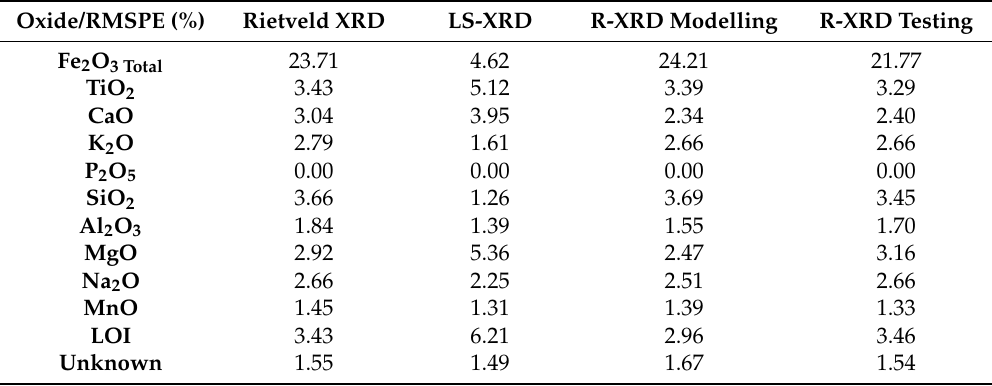
Table 8. Average magnetic separation feed, concentrate, and tailing data RMSPE between measured and estimated XRF. The estimation used average normalized mineral chemistry from Table